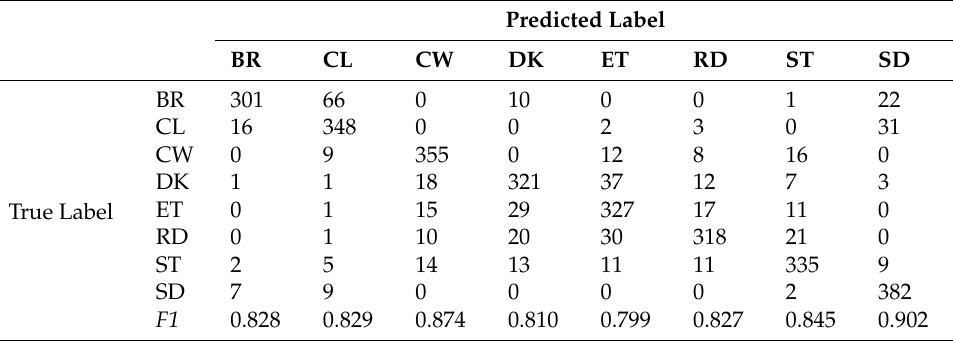
Table 1. Summed confusion matrix from the leave-one-subject-out cross validation.